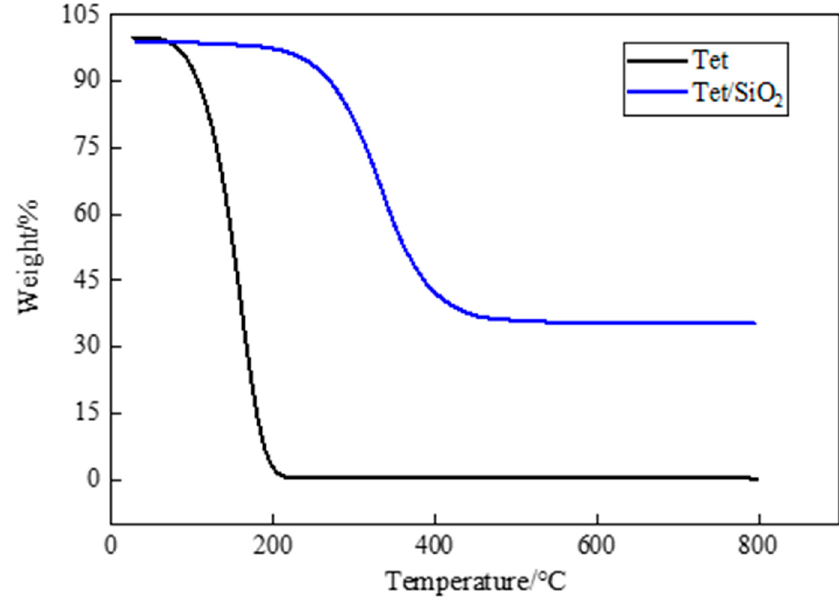
Figure 8. TGA curves of Tet and Tet/ SiO 2 composite shaped PCM.